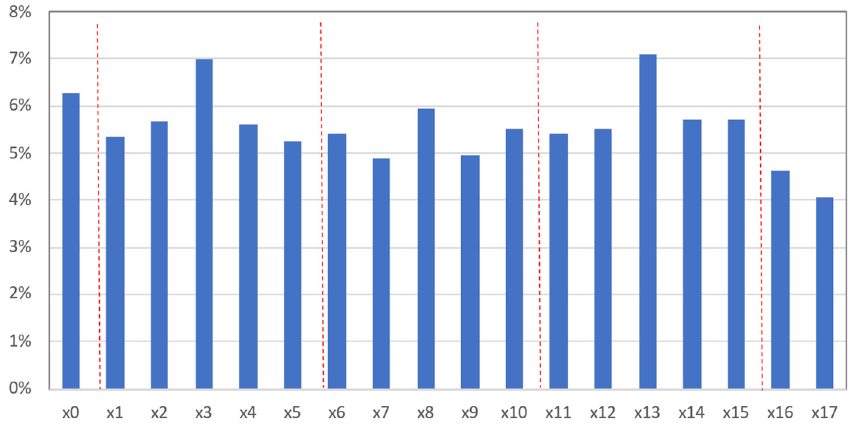
Figure 13. Feature relevance using ANN model.